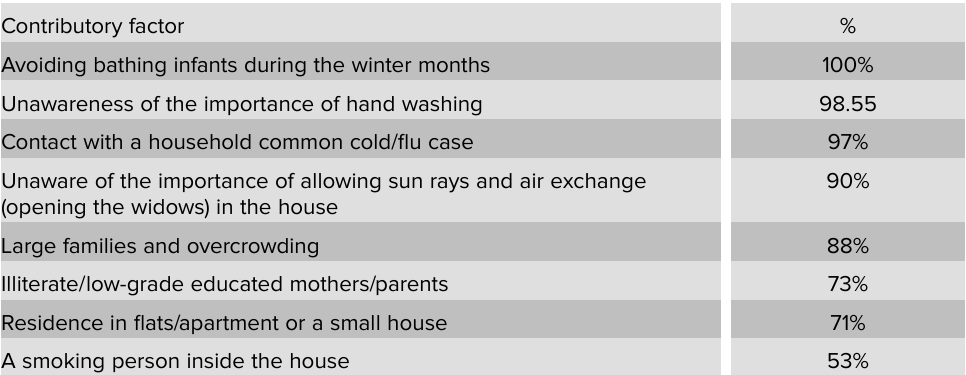
TABLE 6: Contributory factors to